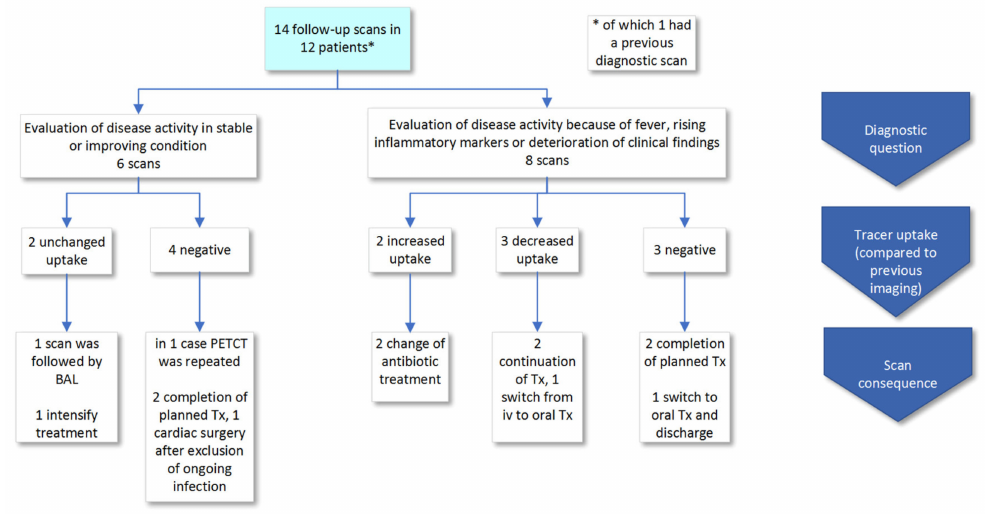
Figure 3. Scan results of FDG-PET / CT scans performed to monitor disease activity (follow-up